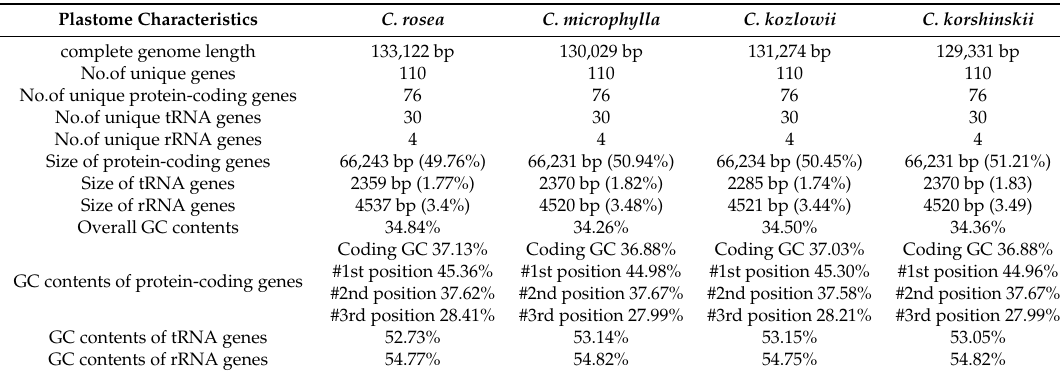
Figure 1. Circular gene map of the C. rosea plastome. Genes drawn inside the circle are transcribed clockwise, and those outside the circle are transcribed counterclockwise. Genes belonging to different functional groups are color codes. The inner circle shows the GC content. The two grey arrows represent the direction of transcription. Table 1. Characteristics of Caragana plastome.